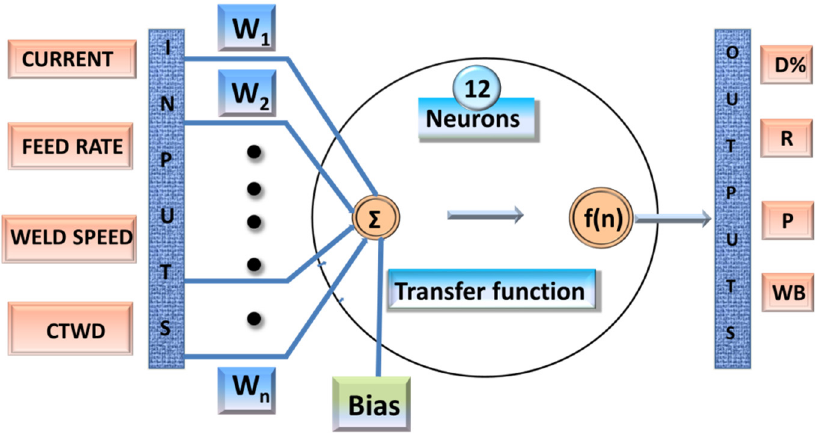
Figure 4. Model of a classical artificial neural network. Back-propagation neural network (BPNN) is a frequently used classification